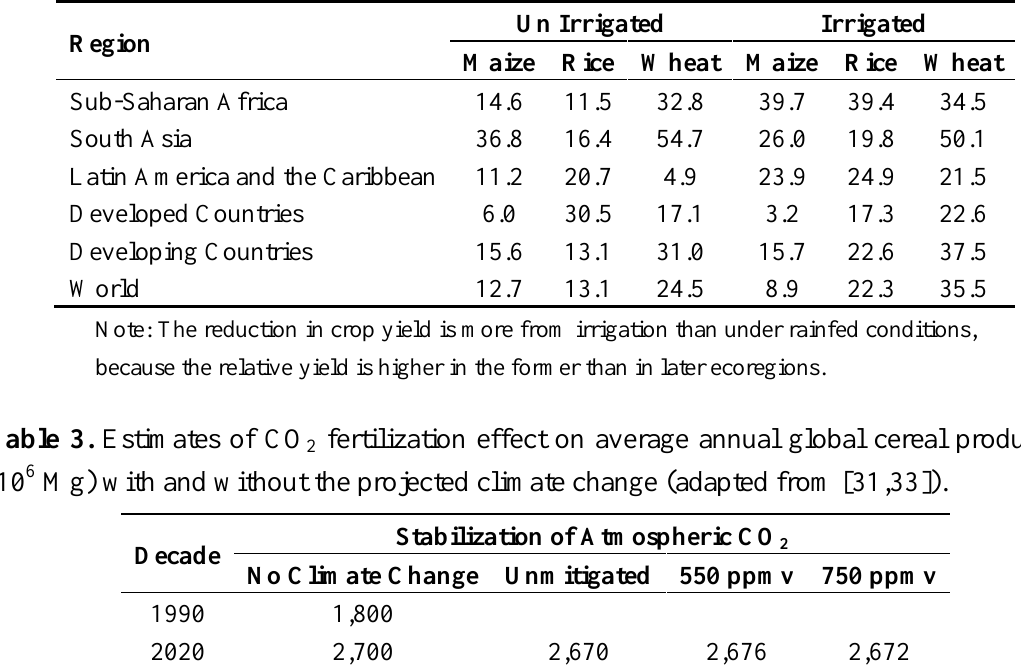
Table 2. Reduction (%) in crop yields by 2050 in global hotpots of climate change (adapted from [31,33]).